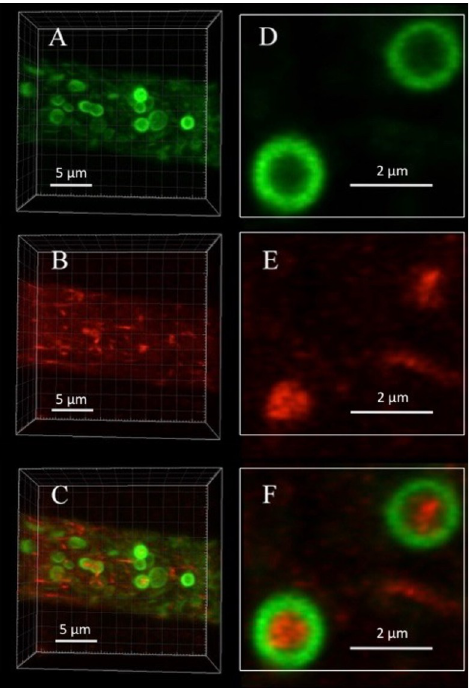
Fig 5. High resolution imaging of dynein within PVCs. PVCs are observed with RAB-7-GFP and dynein with DIC- mCherry. Panels A, B and C are three-dimensional reconstructions from a series of 40 optical sections obtained over a depth of 10 microns. Panels D, E and F are from a single optical